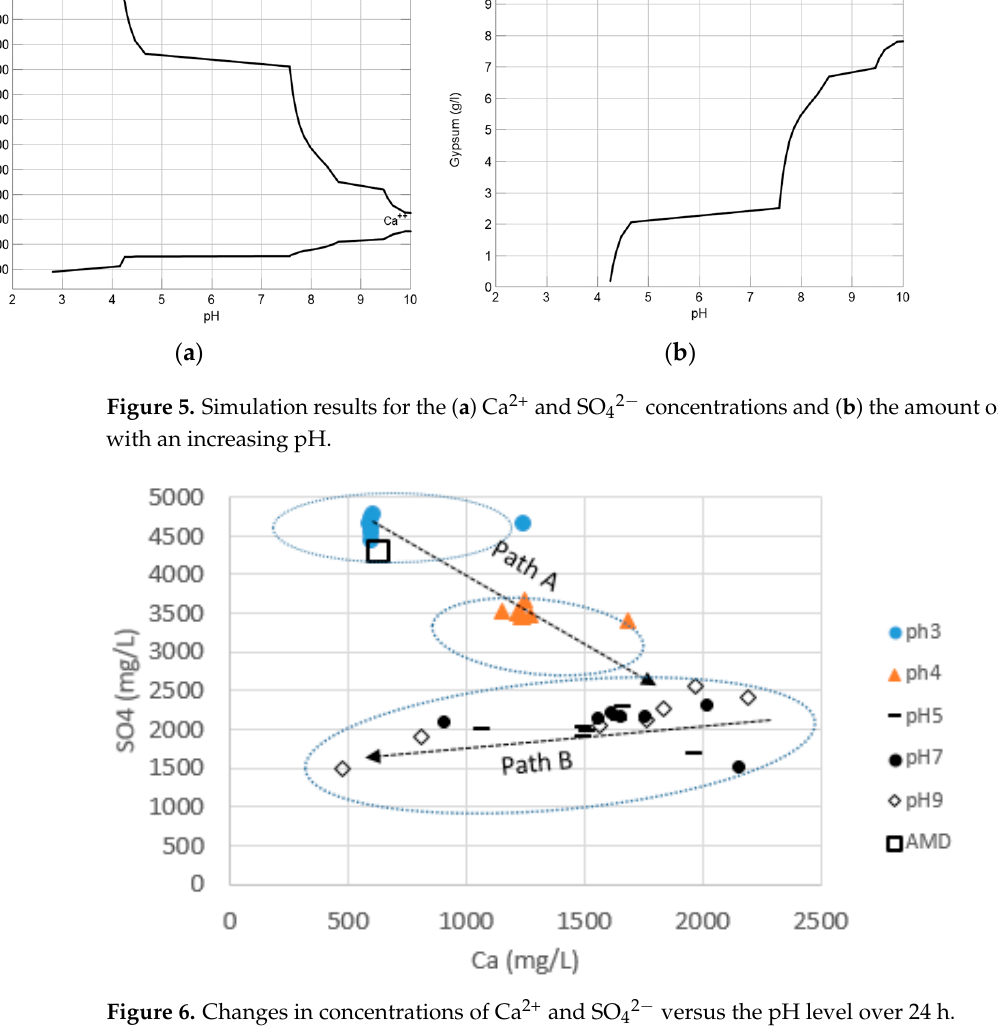
Figure 5. Simulation results for the ( a ) Ca 2+ and SO 42 − concentrations and ( b ) the amount of gypsum with an increasing pH.